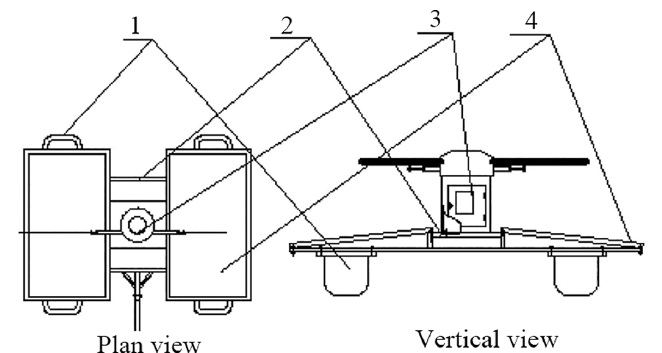
Fig 4. Structure of the walking mechanism of the